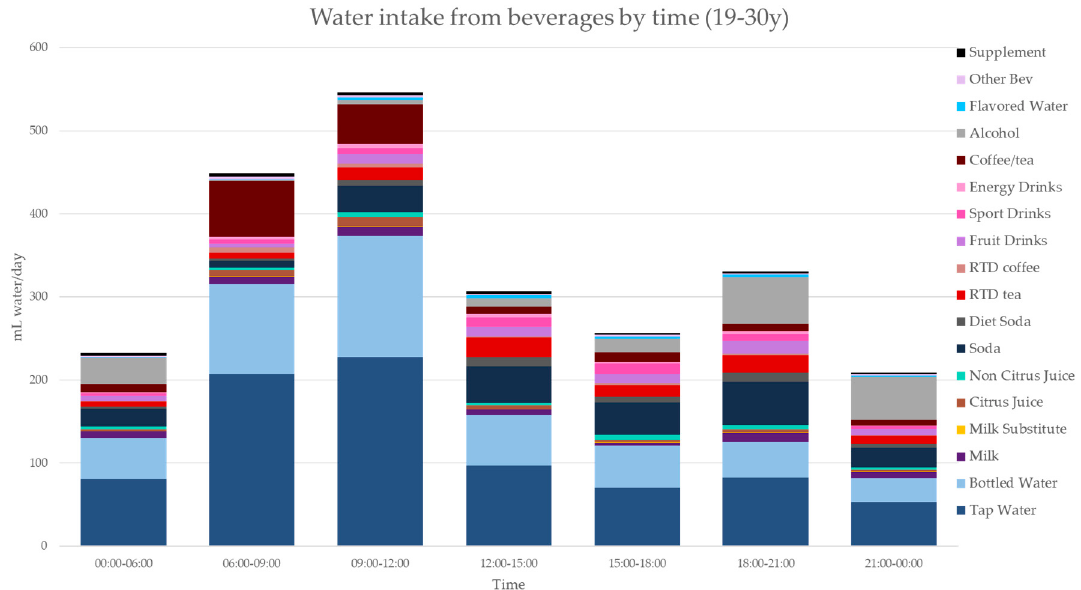
Figure 6. Water intakes (mL / d) by beverage type and time of day for the 19–30 y age group (NHANES 2011–2016).